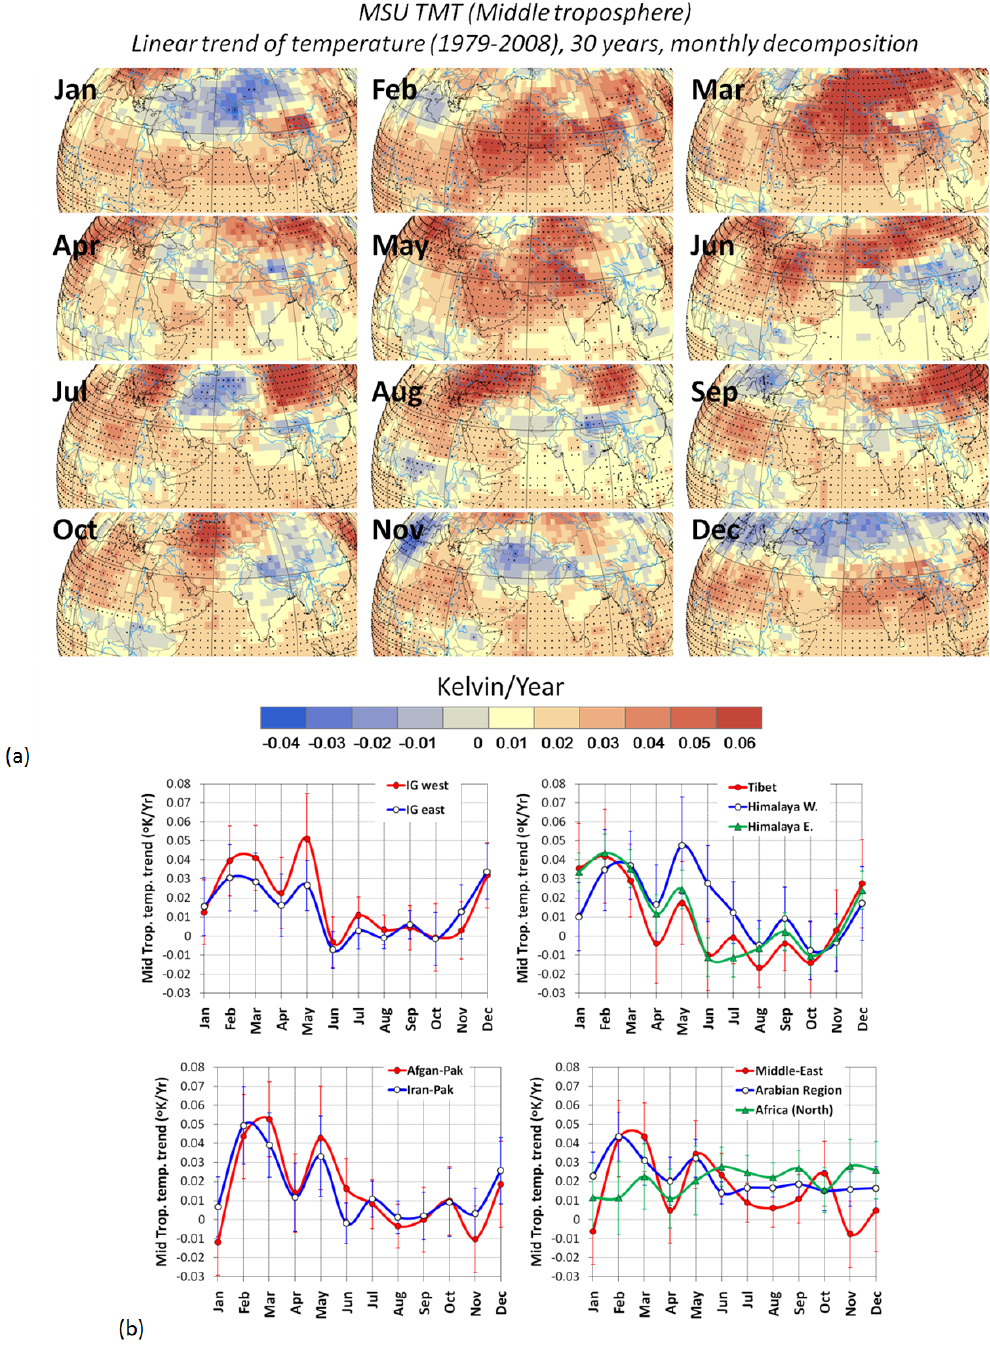
Fig. 3. The month-to-month linear trend ( ◦ Kelvin/year) of brightness temperature based on 30 years (1979–2008) of MSU TMT anomaly data. The month-to-month linear trend is shown over (a) map, and (b) specific study regions (mean trend with standard error) (Fig. 1b). The black dot at the center of any box (a) represent that the calculated linear trend value is statistically significant at alpha 0.05 (95%